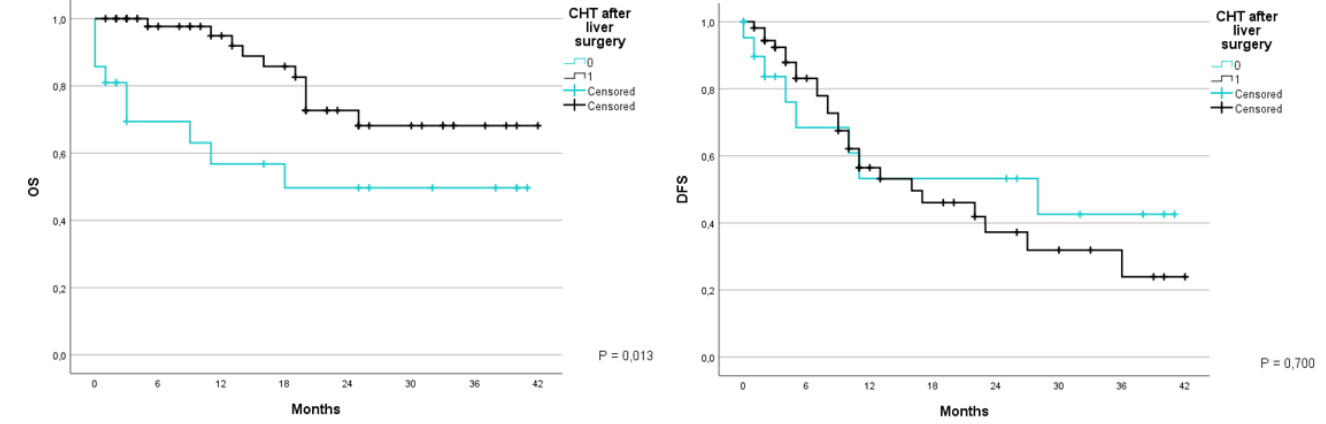
Figure 6. Kaplan-Meier Curve for OS and DFS in patients who underwent liver resection for CRLM stratified according whether the patient had adjuvant chemotherapy or not: Overall Survival; DFS: Disease Free Survival; CRLM: Colorectal liver metastasis; CHT: chemotherapy.